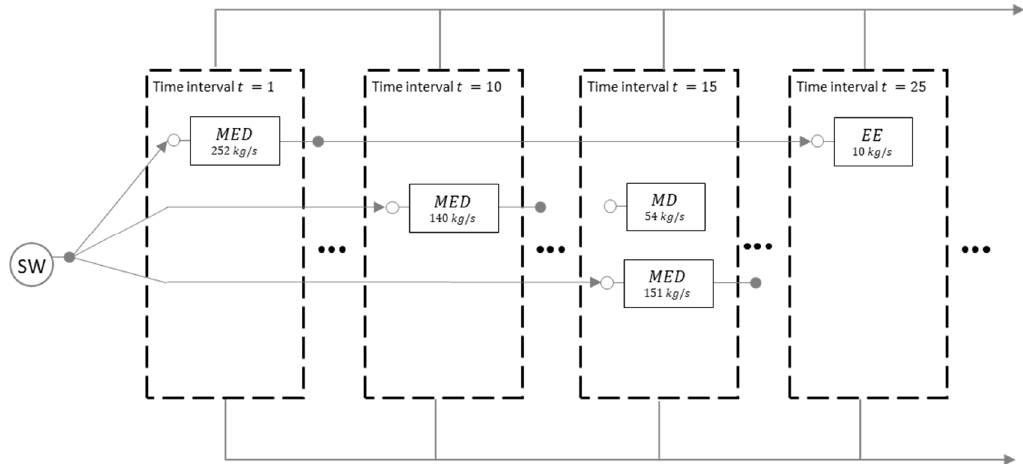
Figure 7. Results for Scenario #2.